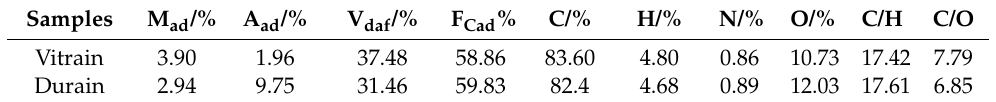
Table 2. Results of proximate and ultimate analysis of vitrain and durain.